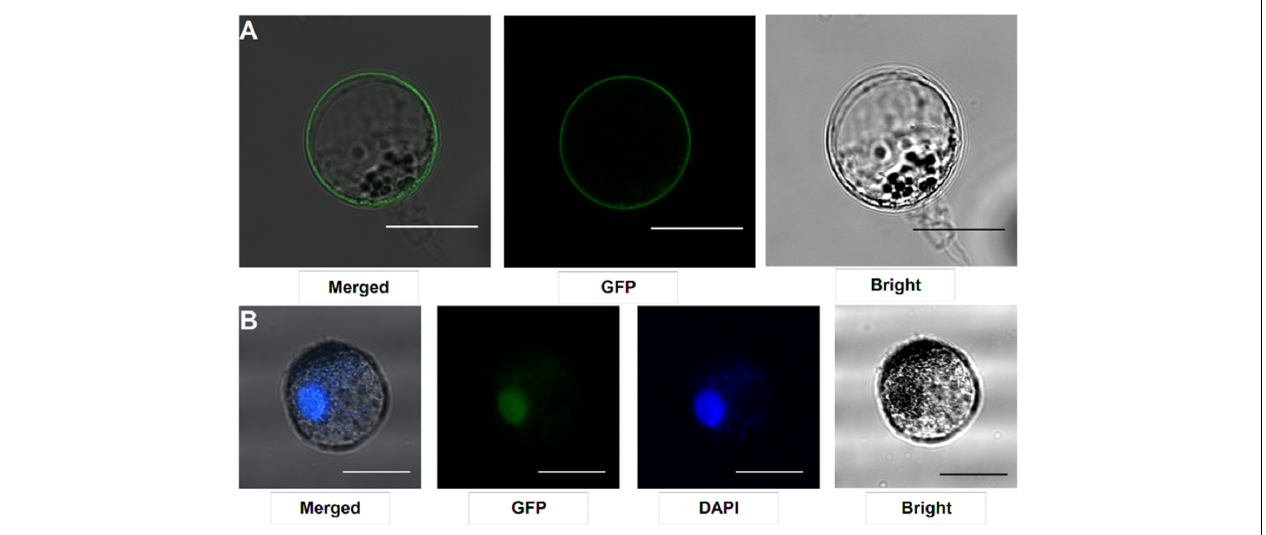
FIGURE 4 | Subcellular localization analysis in L. japonicus root protoplasts. (A) SYMRK-GFP targeted to plasma membrane in Gifu root protoplasts. (B) ERN1-GFP nuclear-localized expression patterns in Gifu root protoplasts, the nucleus-localization was merged with DAPI staining. Scale bars = 25 µ m. Transfection efficiency (SYMRK) = 10.7%; Transfection efficiency (ERN1) = 13.6%.